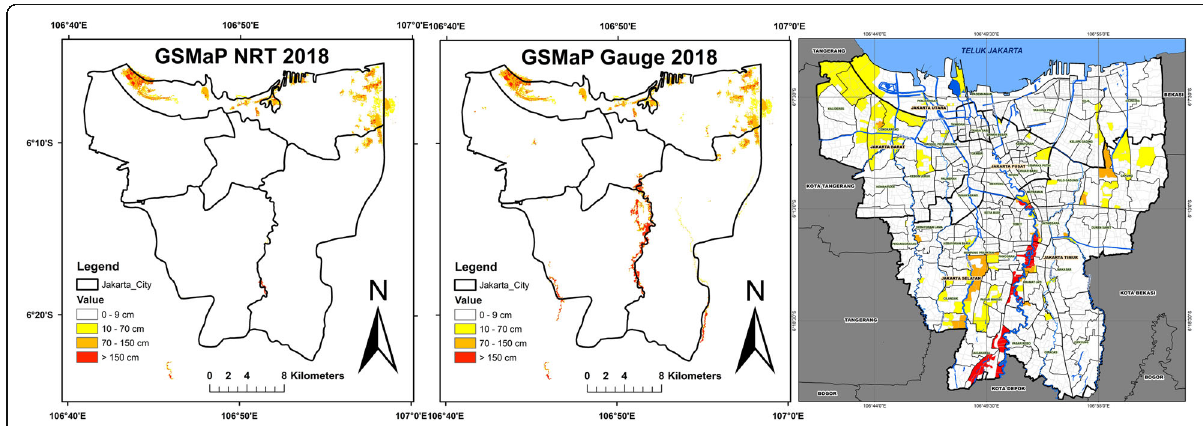
Fig. 15 Flood inundation comparisons for flood event of